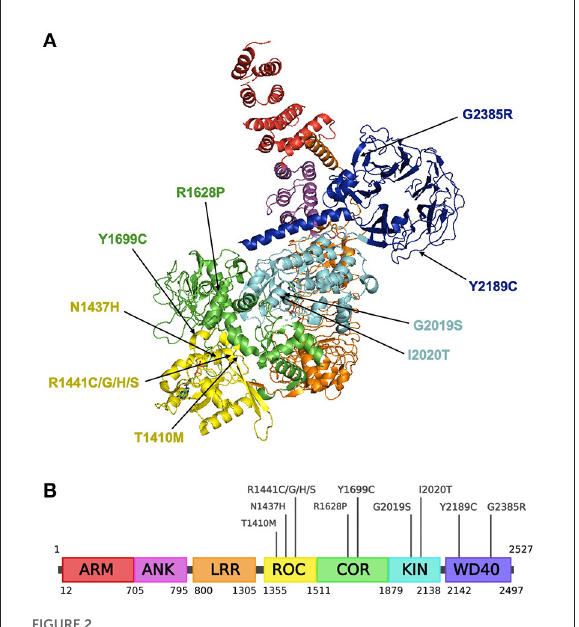
FIGURE2 Structure of the LRRK2 protein and residing pathogenic variants. (A) Structural ribbon model of the LRRK2 monomer. PDB: 7LHW. This figure was created using The PyMOL Molecular Graphics System, Version 2.0 Schrödinger, LLC. (B) Full-length LRRK2 protein. Created with